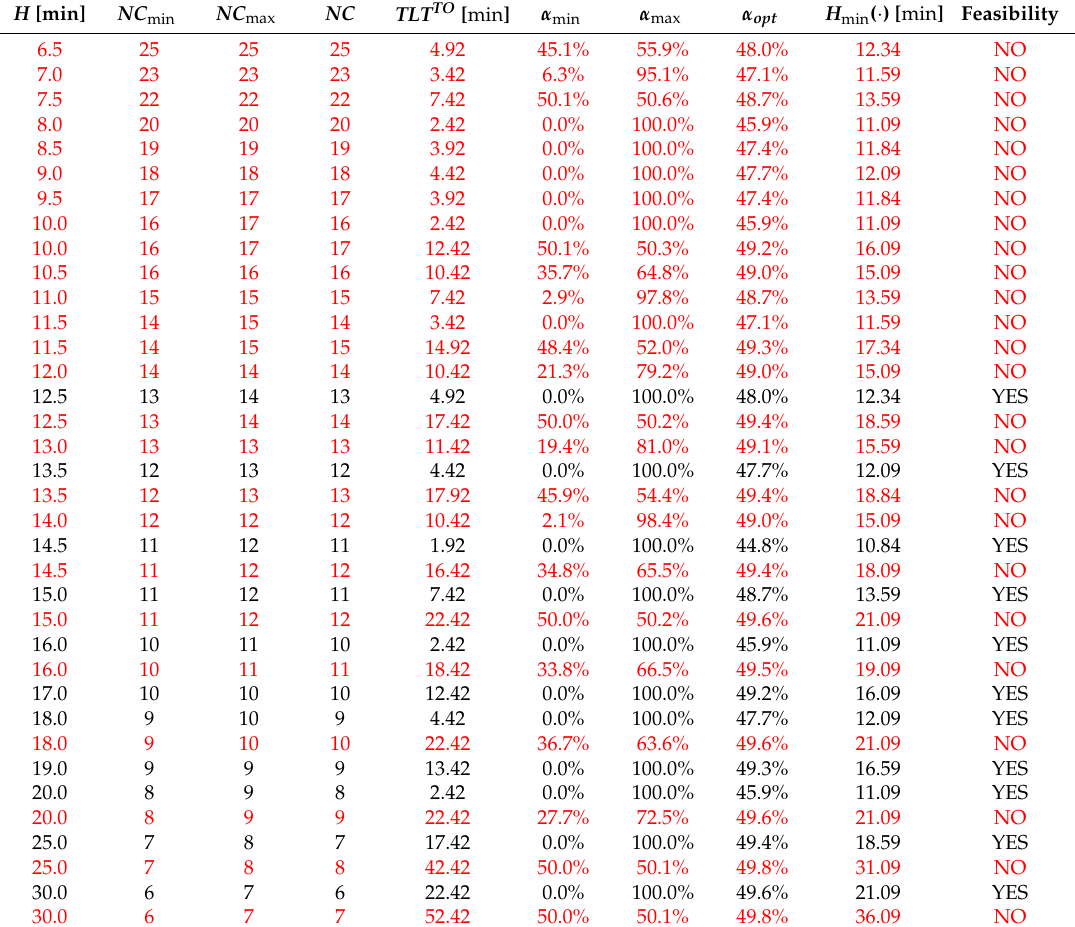
Table 2. Operational schemes in the case of 90th percentile (black = feasible configurations; red = unfeasible configurations).